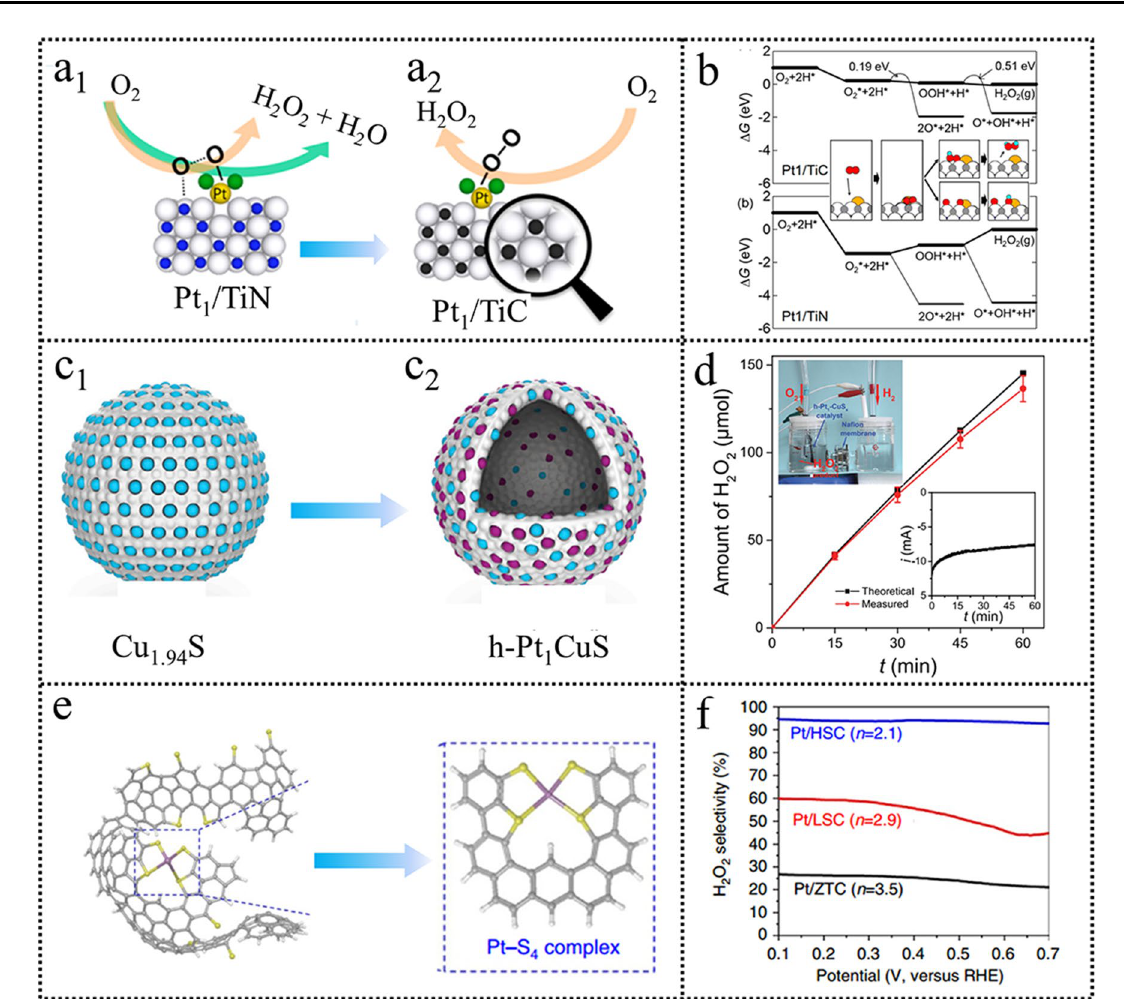
Fig. 8 a , b Schematic of TiN and TiC support effect and free-energy diagrams at 0.2 V for the ORR on Pt/TiC(100) and Pt/TiN(100). Repro- duced with permission [76]. Copyright 2016, American Chemical Society. c , d Schematic illustration of the structure evolution of h-Pt 1 -CuS x and H 2 O 2 generation at a cell. Reproduced with permission [77]. e , f Proposed atomistic structure of the Pt/HSC based on the buckybowl-like structure and H 2 O 2 production selectivity. Reproduced with permission [79]. Copyright 2019, Elsevier. (Color figure